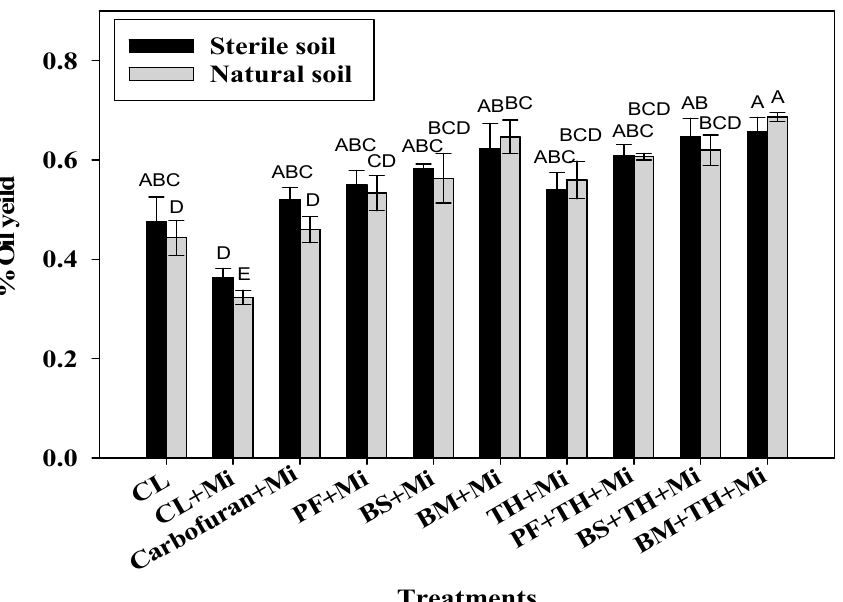
Figure 5. Oil yield of O. basilicum (%) plants grown in sterile (black) and natural soil (grey) conditions under different microbial treatments in single inoculations (BM + Mi, TH + Mi, BS + Mi, PF + Mi) and consortium inoculations (BM + TH + Mi, BS + TH + Mi, PF + TH + Mi). The comparisons were made for all of the treatments of the same experiment, either in sterile soil or natural soil conditions. The vertical bars (mean ± SE) with different letters represent statistically significant values (at p ≤ 0.001) in comparison to untreated inoculated control (CL +Mi).